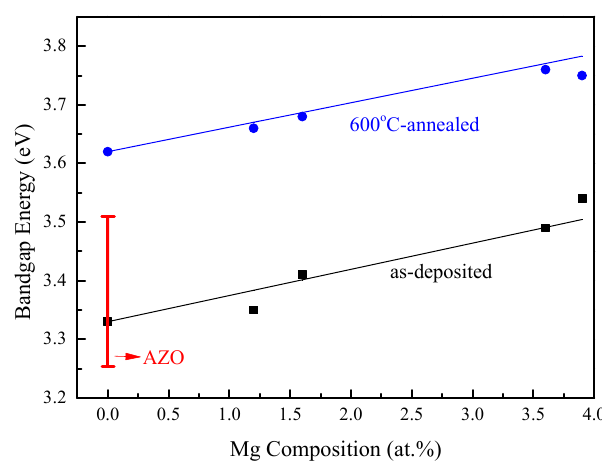
Figure 5. Summary of bandgap obtained for Mg-doped AZO films with different Mg doping concentrations. Solid lines present the bandgap trend predicted by Vegard’s law; the red line is the bandgap of AZO referred to the literature.